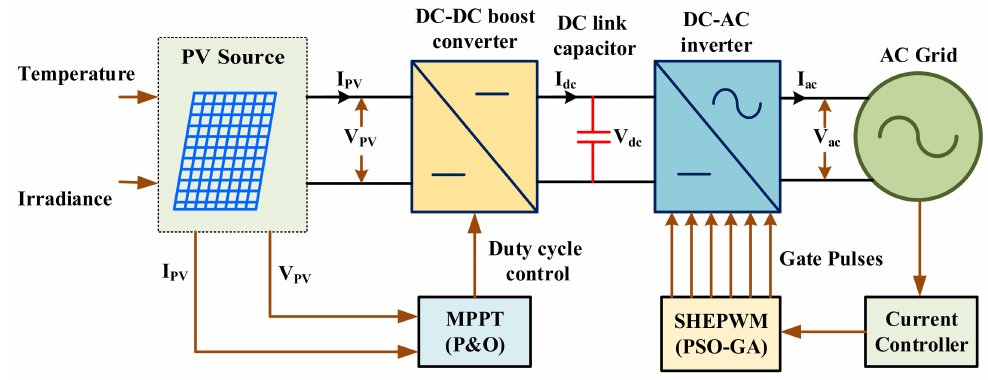
Figure 2. Proposed two-stage grid-connected SPV